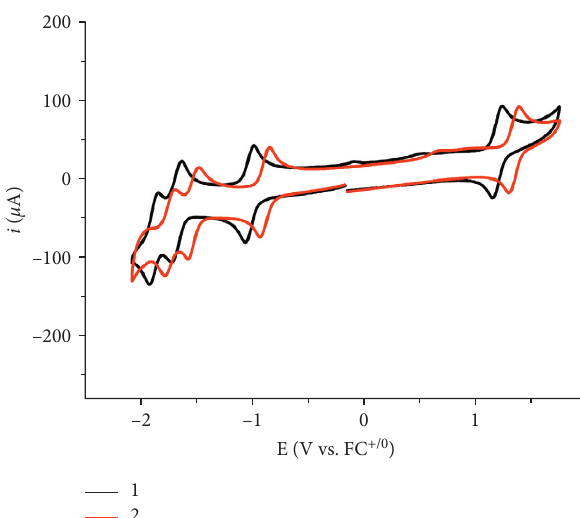
Figure 1: Normalized UV-Vis and emission spectra of complexes 1 (red trace) and 2 (blue trace) in acetonitrile. Table 2: Spectroscopic properties for complexes 1 and 2. Compound